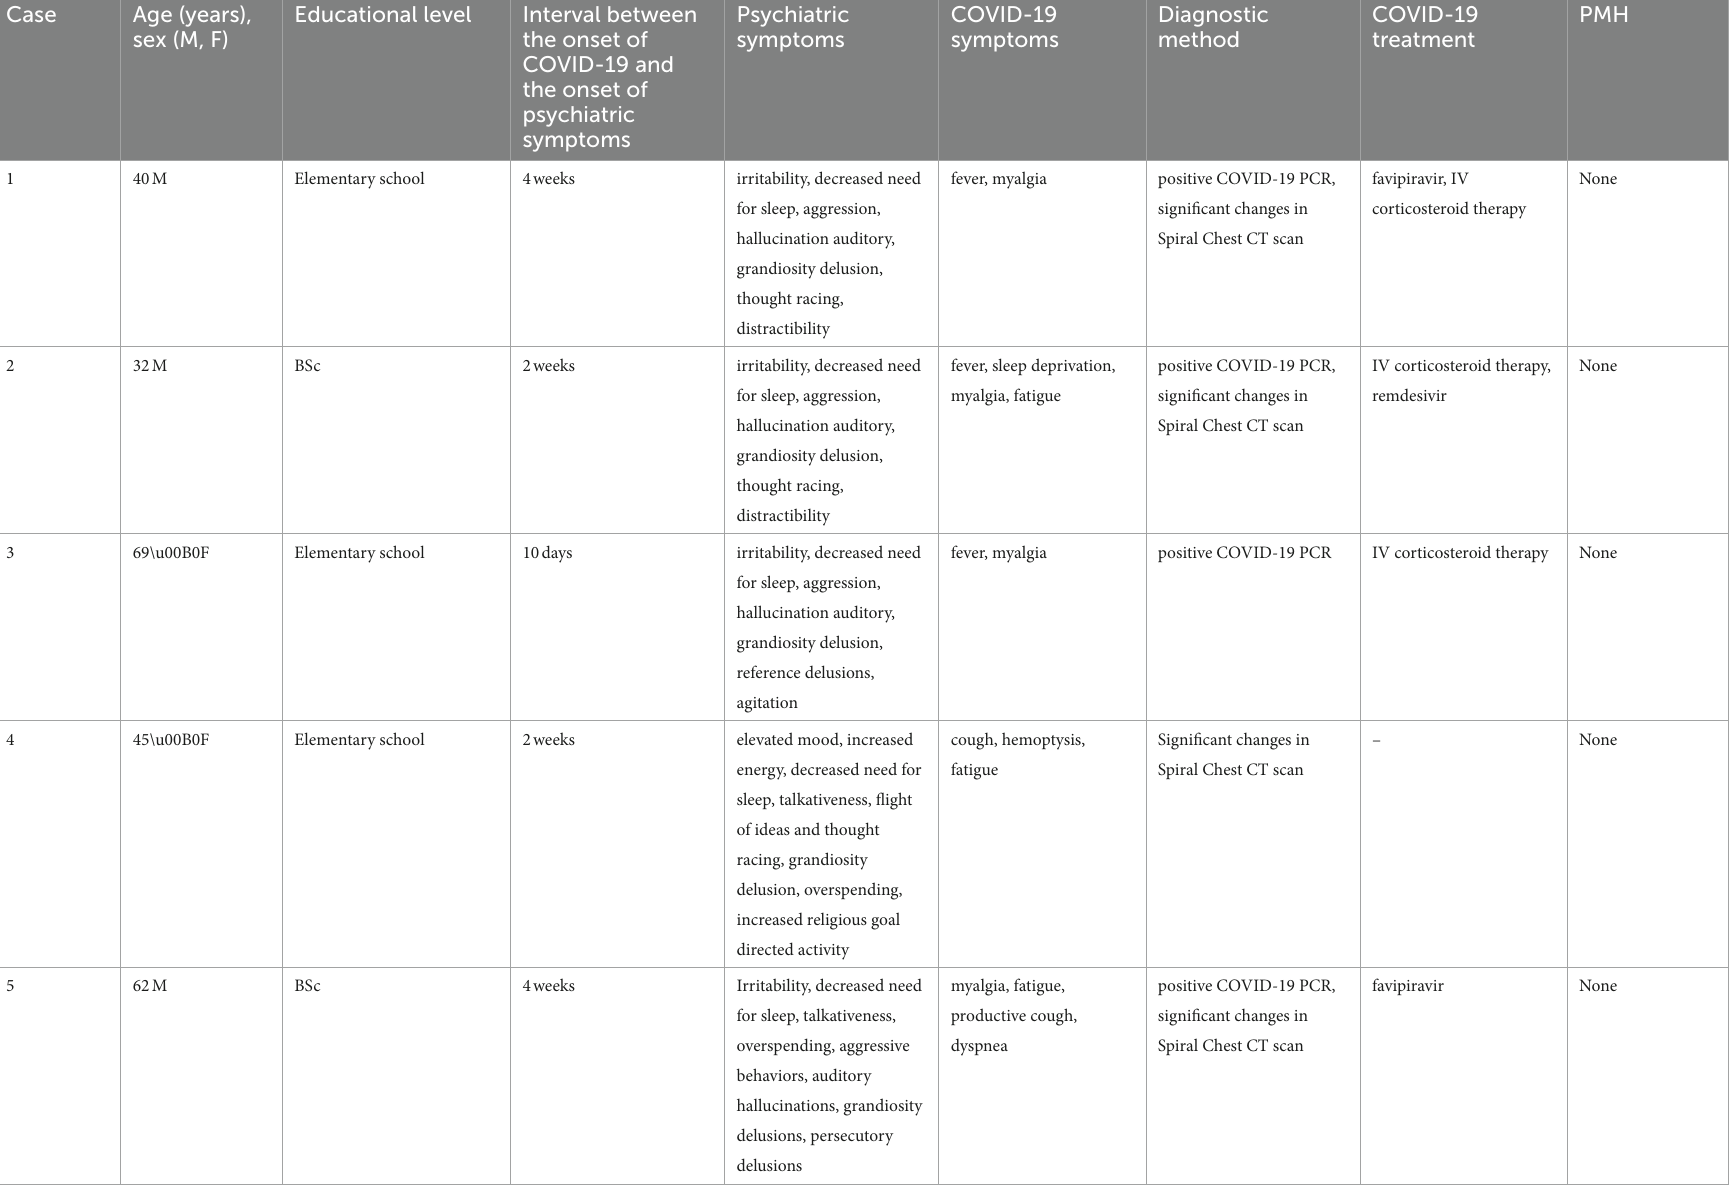
TABLE 1-1 Characteristics of patients with post-COVID mania in the case series.